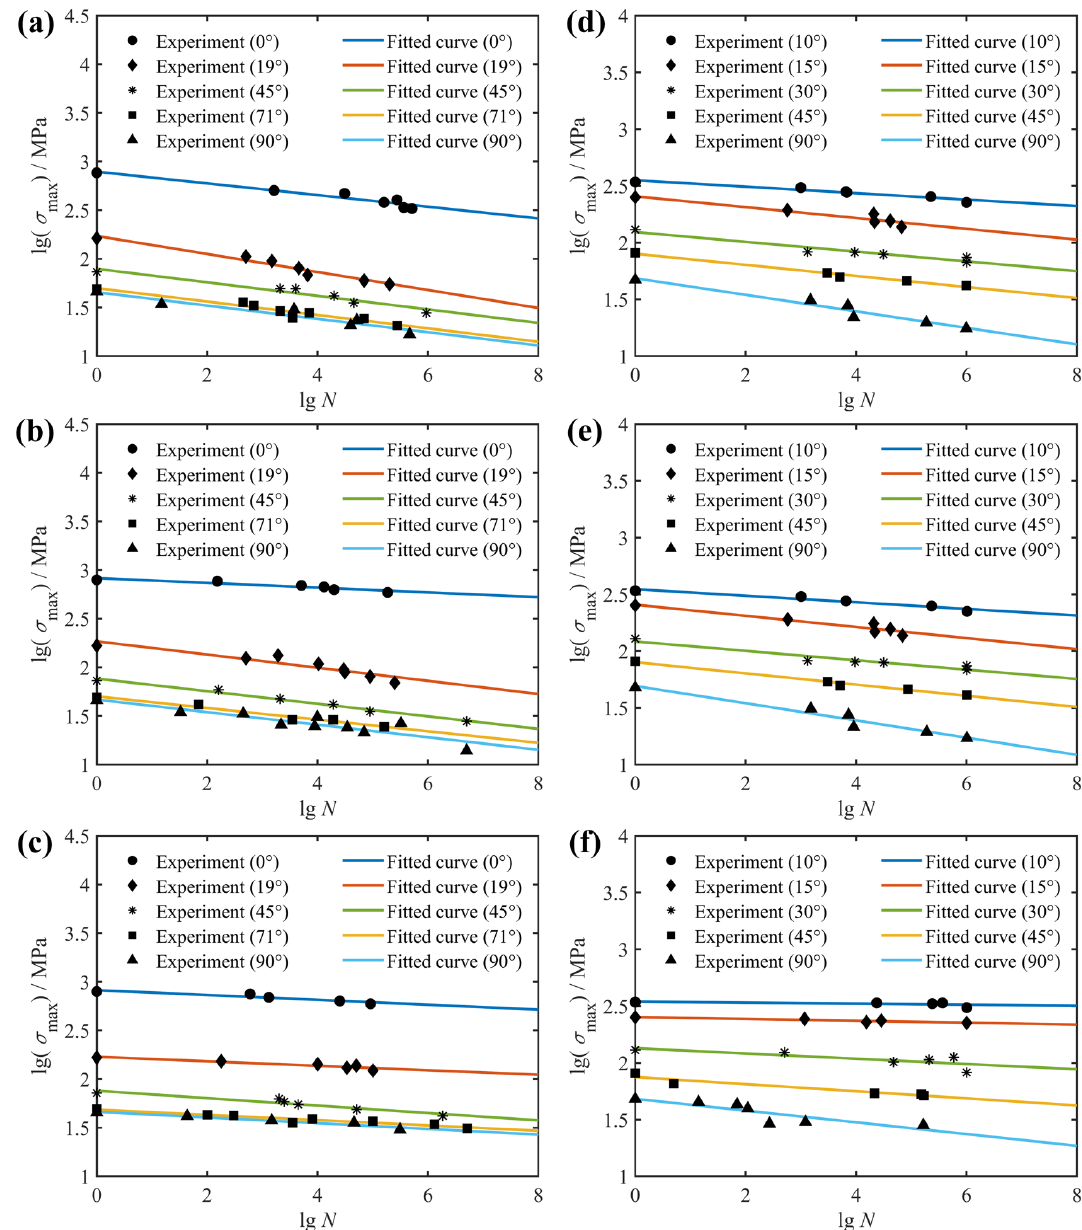
Figure 2. Effect of fiber orientation on fatigue life of unidirectional E-glass/epoxy [32] ( a – c ) and T800H/2500 [30] ( d – f ) specimens at stress ratio of: ( a ) R = − 1; (2) R = 0; ( c ) R = 0.5; ( d ) R = − 1; ( e ) R = 0.1; ( f ) R = 0.5.